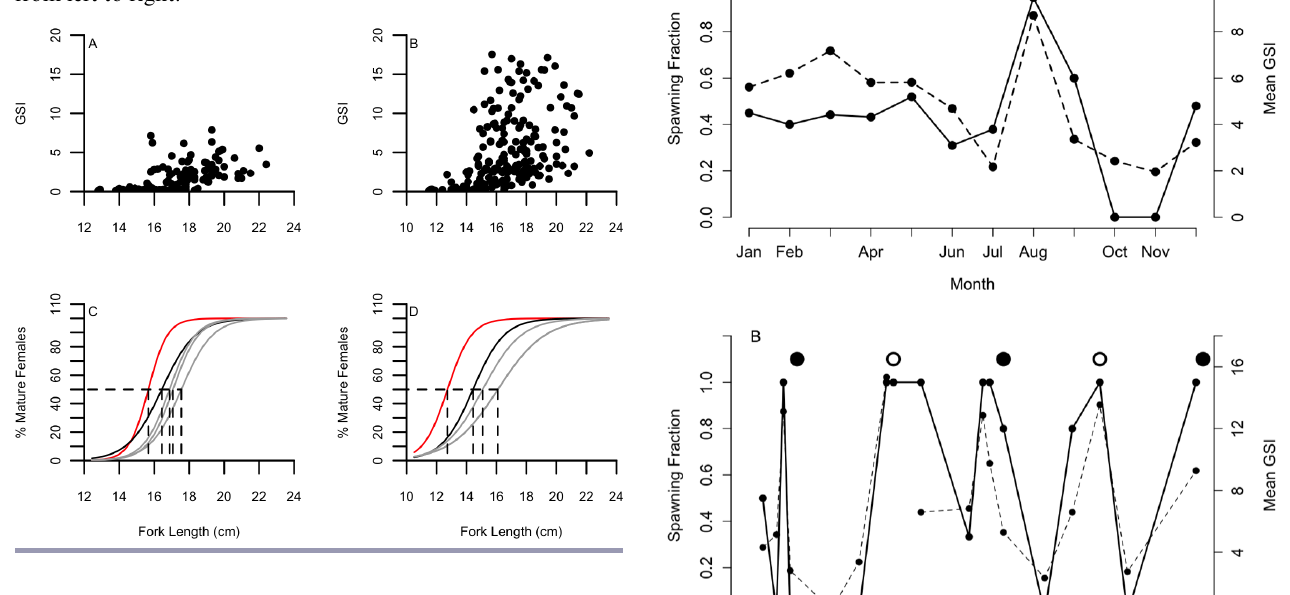
Fig. 4 . Comparing gonadosomatic index (GSI) to histological Fig. 5 . Comparison of gonadosomatic index (GSI) and assessment of size at maturity for manini (convict tang, spawning fraction to determine timing of spawning in manini Acanthurus triostegus sandvicensis ) from North Kona (A and C) (convict tang, Acanthurus triostegus sandvicensis ). (A) Monthly and Maunalua Bay (B and D). Individual fish GSI values are mean GSI and spawning fraction to assess the spawning season plotted in the top panels for North Kona (A) and Maunalua for manini from Maunalua Bay in 2013. Dashed line represents Bay (C). Bottom panels display the size at maturity GSI. (B) Daily mean GSI and spawning fraction to assess the assessments. Dashed lines indicate the size at which 50% of the lunar spawning pattern for manini from Maunalua Bay. Moon population is capable of spawning (L ) based on each method. phase (new (black circle) and full (open circle)) are illustrated 50 The histologically assessed size at maturity is in red. The black on top of figure. Dashed line represents GSI and spawning line represents the 5% maximum GSI assessed maturity, the fraction is represented by a solid black line. gray lines are the 10, 15, and 20% maturity assessments moving from left to right.